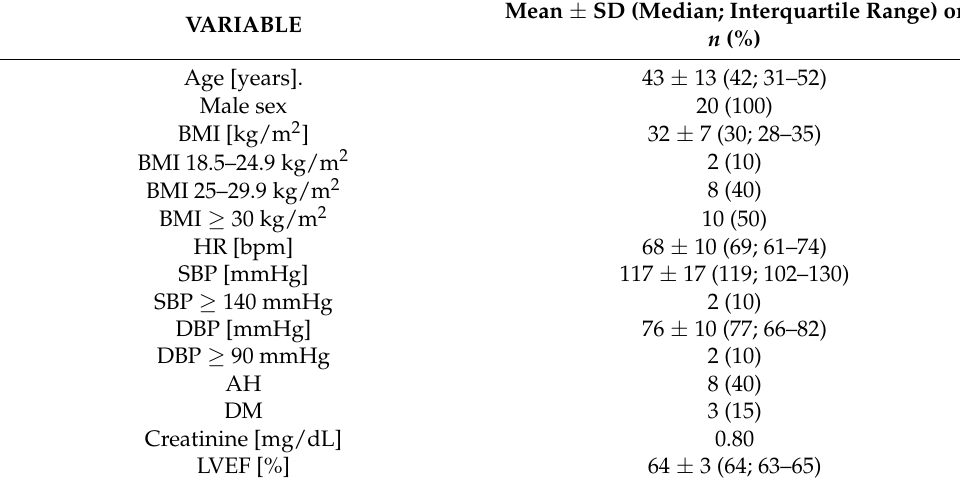
Table 1. Baseline characteristics of the patients with